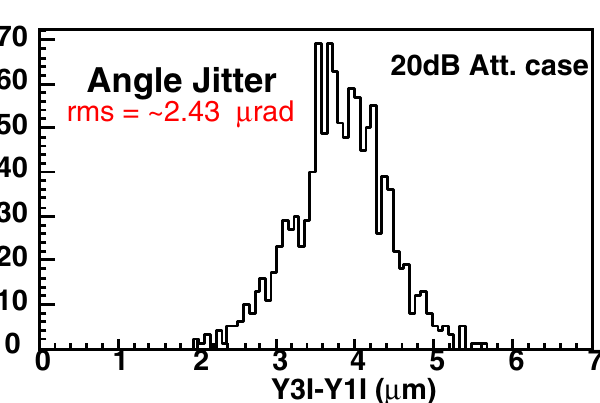
FIG. 16. (Color) Typical beam jitter. The top figure is the statistics of vertical beam position (Y) measured at the 2nd cavity BPM. The bottom figure is the vertical beam angle ( Y 0 ) tracked by 1st and 3rd cavity BPMs.